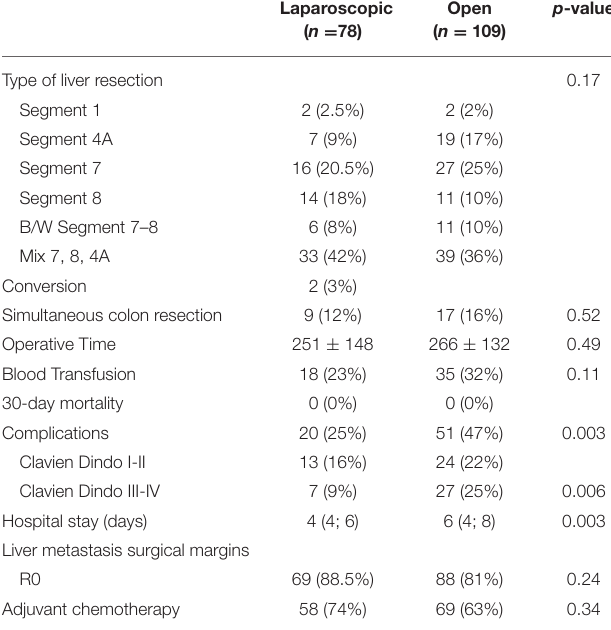
TABLE 2 | Surgical and histological results.